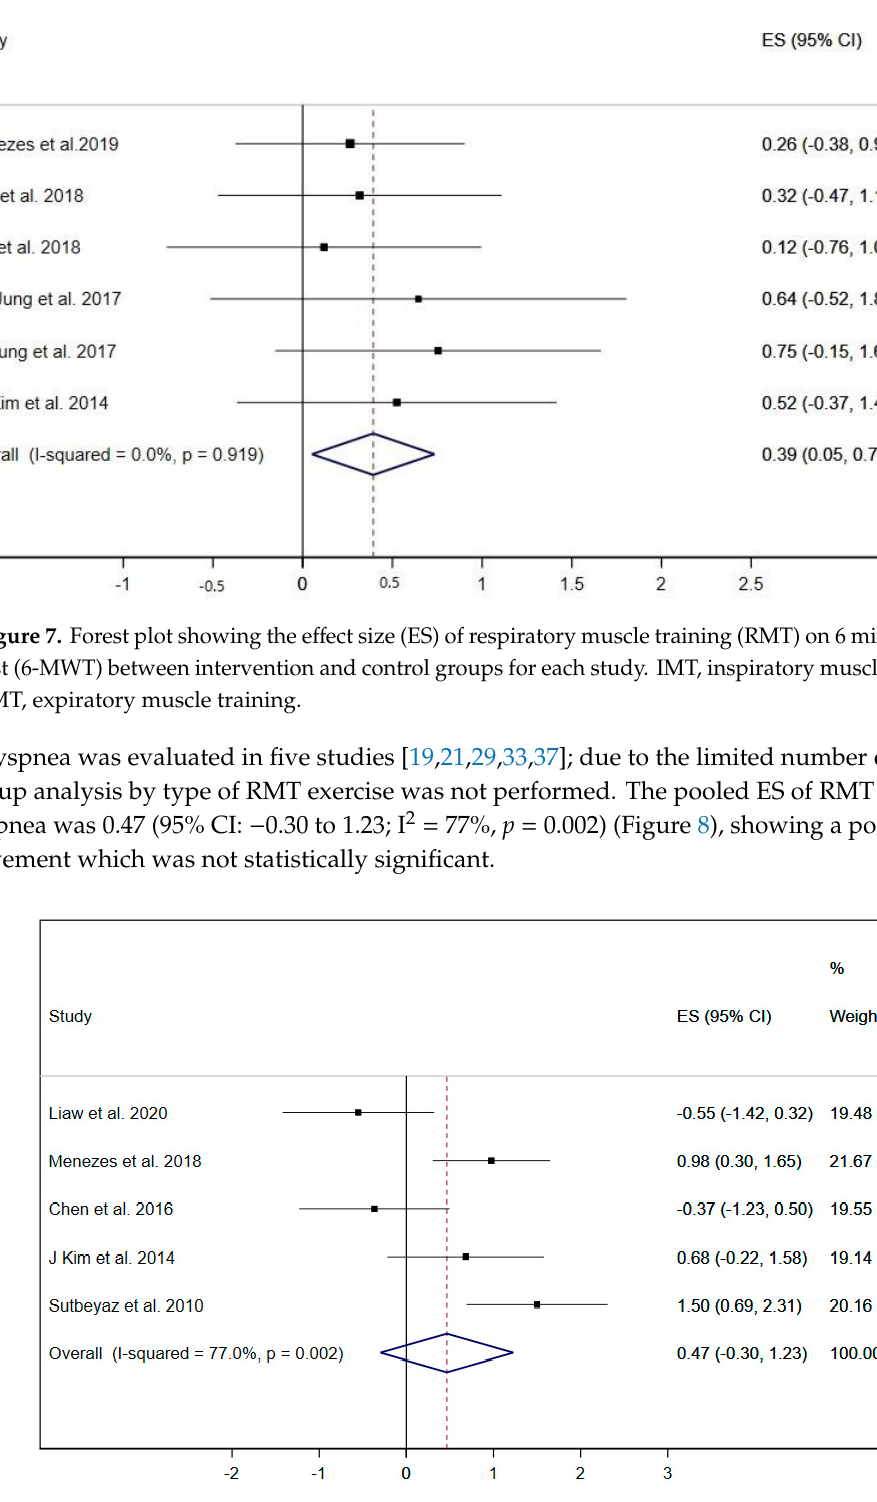
Figure 8. Forest plot showing the e ff ect size (ES) of respiratory muscle training (RMT) on dyspnea between intervention and control groups for each study. IMT, inspiratory muscle training; EMT, expiratory muscle